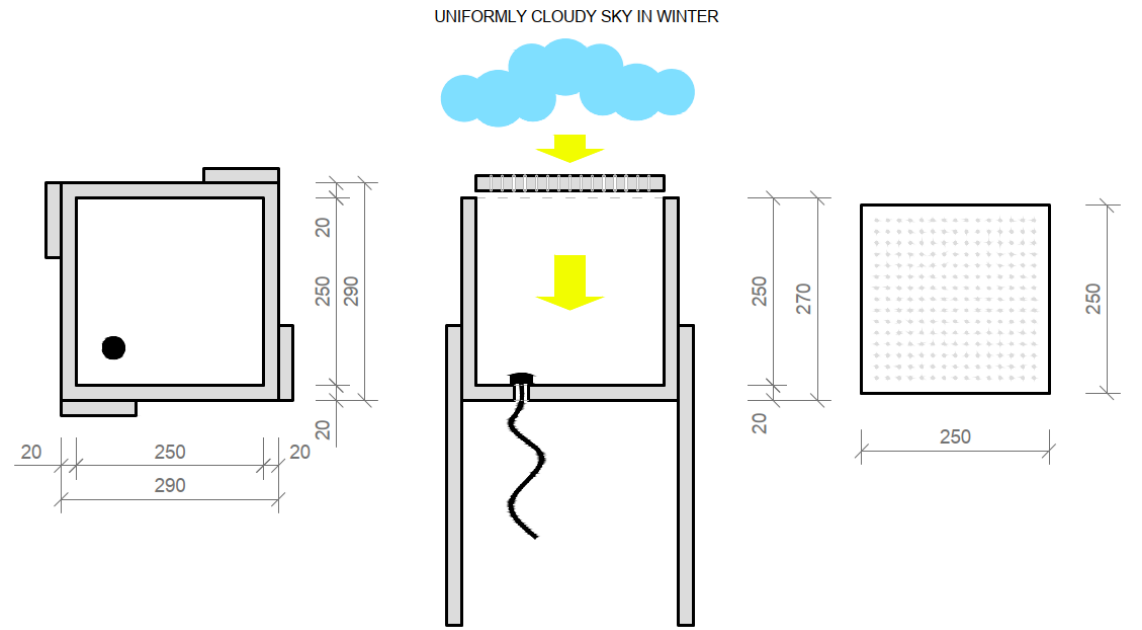
Figure 25. Plans and sections of the scaled-down model.